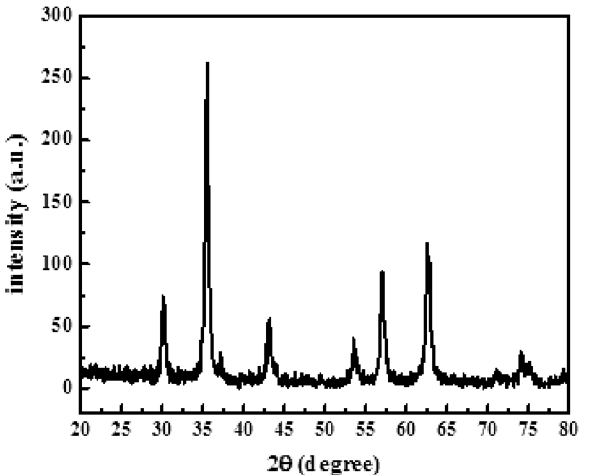
Figure 2. Results of XRD analysis for CoFe 2 O 4 MNP.